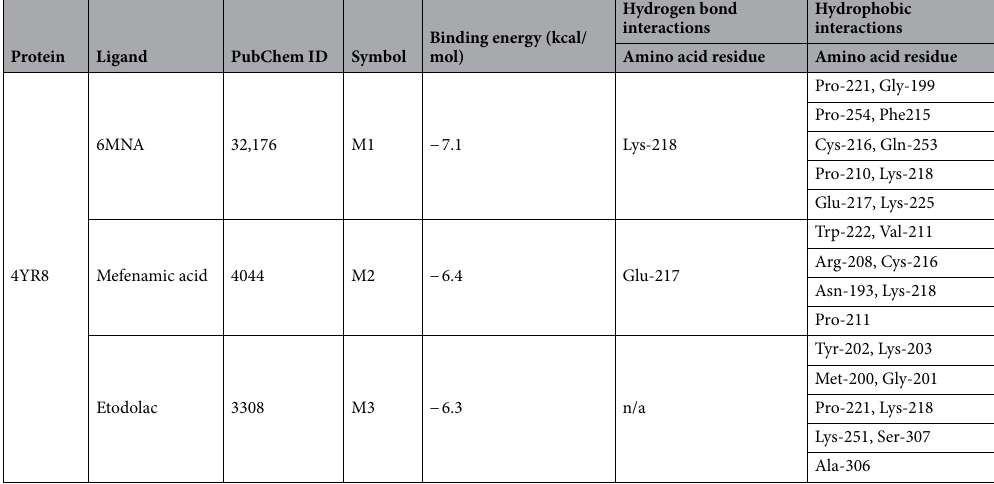
Table 3. Binding energy and interactions of potential three NSAIDs on MAPK8 (PDB